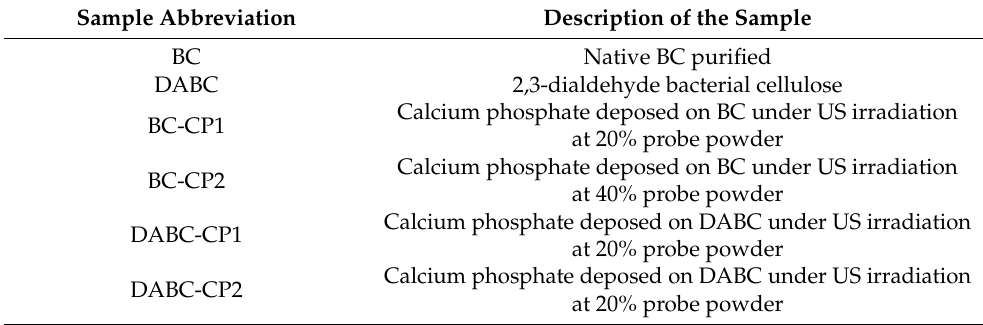
Table 1. Synthesis conditions for all the samples and their symbolic notations. Sample